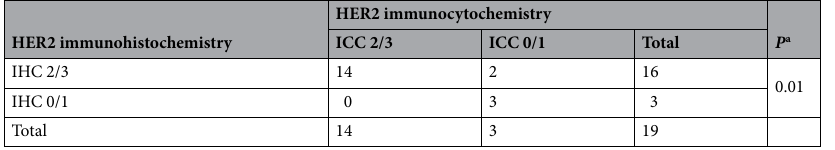
Table 3. Comparison of HER2 immunocytochemistry and immunohistochemistry in dogs with urothelial carcinoma. a Fisher’s exact